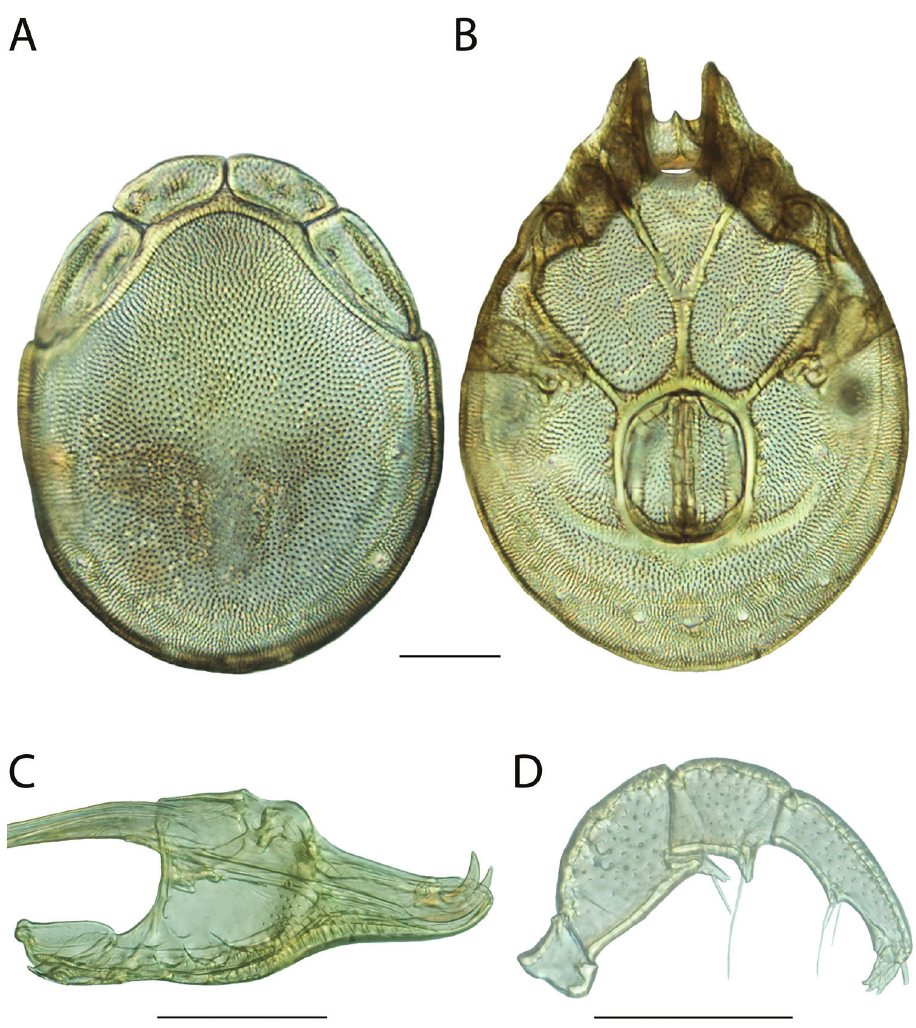
Figure 242. Torrenticola sierrensis male: A dorsal plates B venter (legs removed) C subcapitulum D pe- dipalp (setae not accurately depicted). Scale = 100